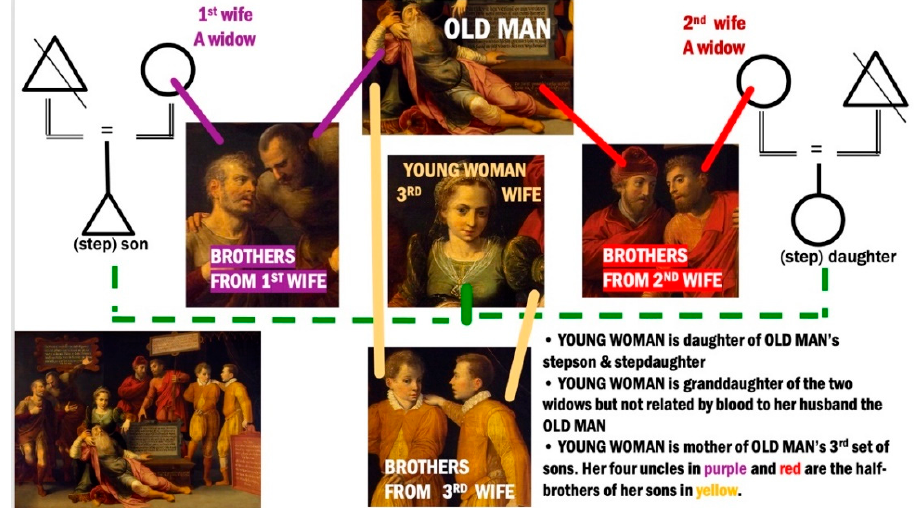
Figure 6. Solution to the 1576 riddle painting. Insets: Cornelis Ketel (attribution). Riddle of Nijmegen , 1576, Museum Het Valkhof, Nijmegen, Netherlands, inventory number: C.XVI.233. Oil painting on wood, 78.5 cm × 107.5 cm. Photo: Museum Het Valkhof, Nijmegen, The Netherlands. Drawing credit: Lyndan Warner.